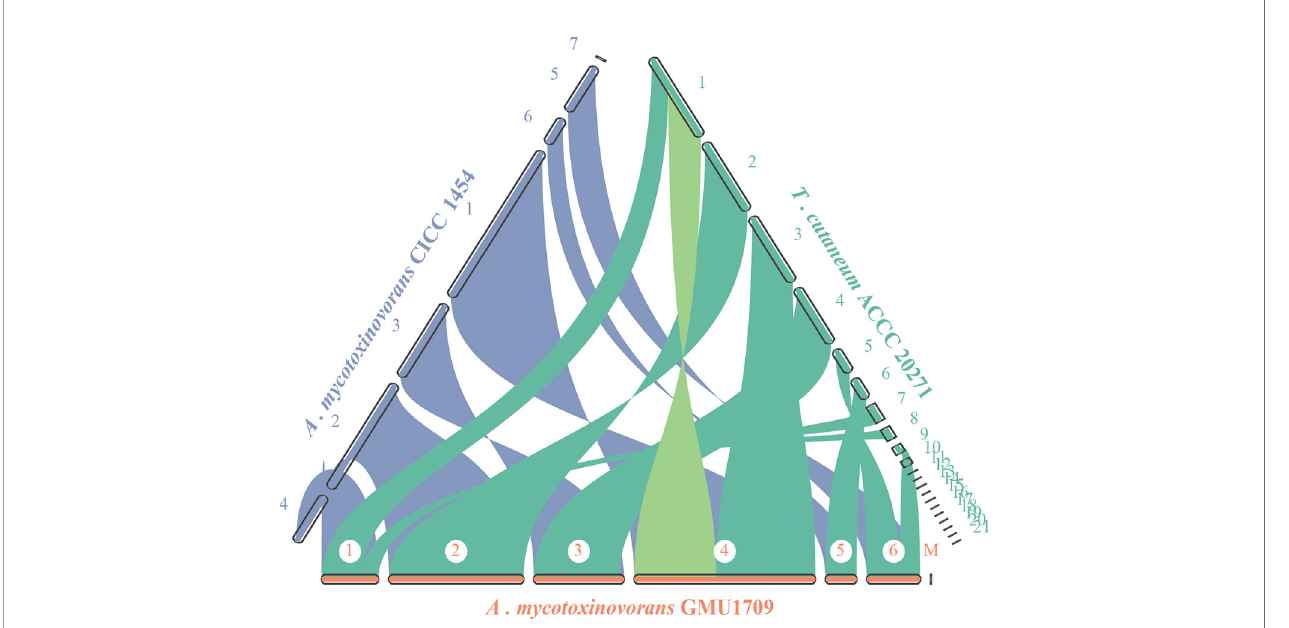
FIGURE 4 | Synteny analysis of A. mycotoxinivorans GMU1709 and CICC 1454 and formerly T. cutaneum ACCC 20271 using JCVI v1.0.1 software. Synteny patterns show that each genomic block of GMU1709 strain aligns with one genomic block of CICC 1454 and ACCC 20271 strains. Dubious region in one scaffold of ACCC 20271 genome assembly is highlighted in light